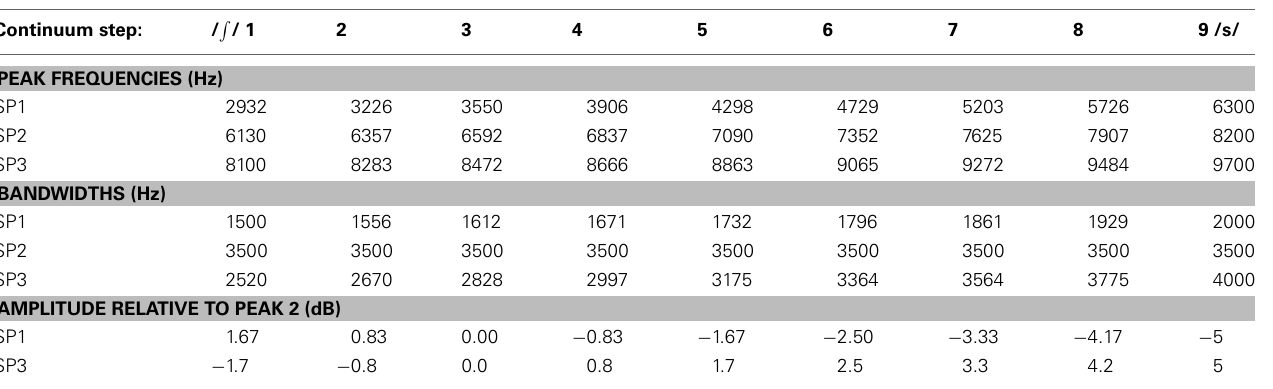
Table 2 | Acoustic description of the fricative